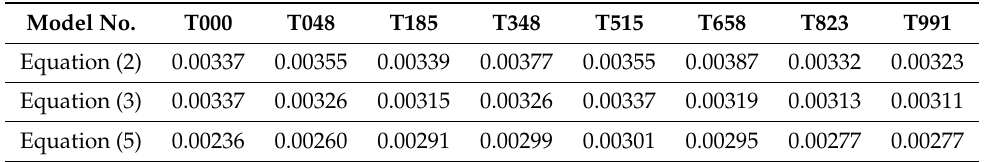
Table 2. Fitting accuracy of three V-I